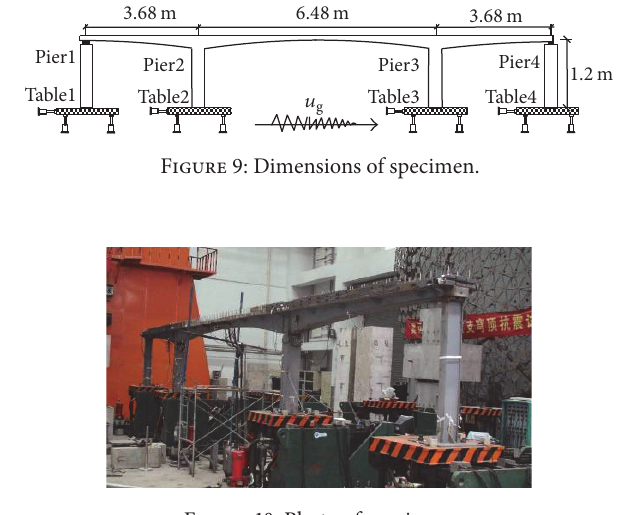
Figure 10: Photo of